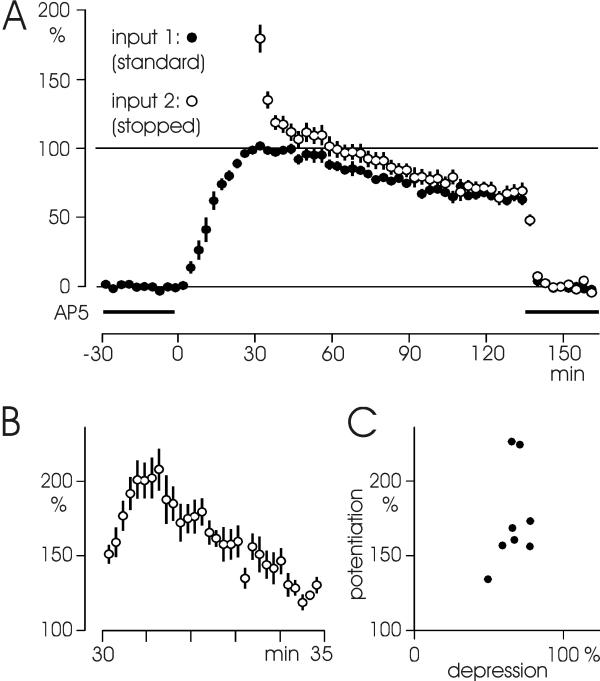
Transient potentiation induced by sudden activation of NMDA receptors. (A) Superimposed averaged time courses of NMDA EPSPs for two pathways subjected to different stimulation protocols. Each point represents the average of measurements within 3 min intervals. Stimulation of one pathway (input 2) was stopped for a period of 30 min and then restarted at a time point when NMDA receptors were fully unblocked as judged by responses for the other pathway (input 1) that was exposed to the standard protocol. The peak of input 1 was taken as 100 %. (B) Time course of the newly evoked NMDA responses. Expanded portion of A immediately following restart of stimulation, each point representing measurement of a single EPSP. It can be noted that following the initial response there was additional growth for about a minute before responses started to decay. Values in both A and B are expressed as mean ± S.E.M (n = 8 experiments). (C) Examining the relation between the slow depression and the transient potentiation of NMDA EPSPs. Depression was quantified as end-of-session value relative to peak value (5 min averages) for input 1 that received the standard protocol. Transient potentiation was estimated as the average of the first 18 responses (3 min) of input 2 relative to the average of the corresponding interleaved responses of input 1. The latter value was nearly the same as the peak value. Each dot represents a single experiment (same set of 8 experiments as in A, B). The analysis revealed no significant correlation between the data points.